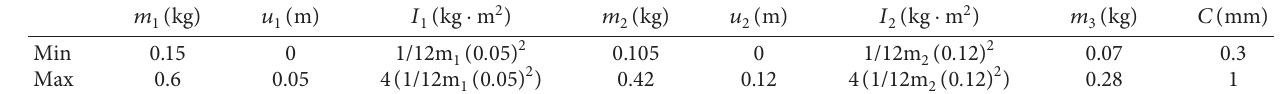
Table 3: Constraints of design parameters and changing amplitude of joint clearances.